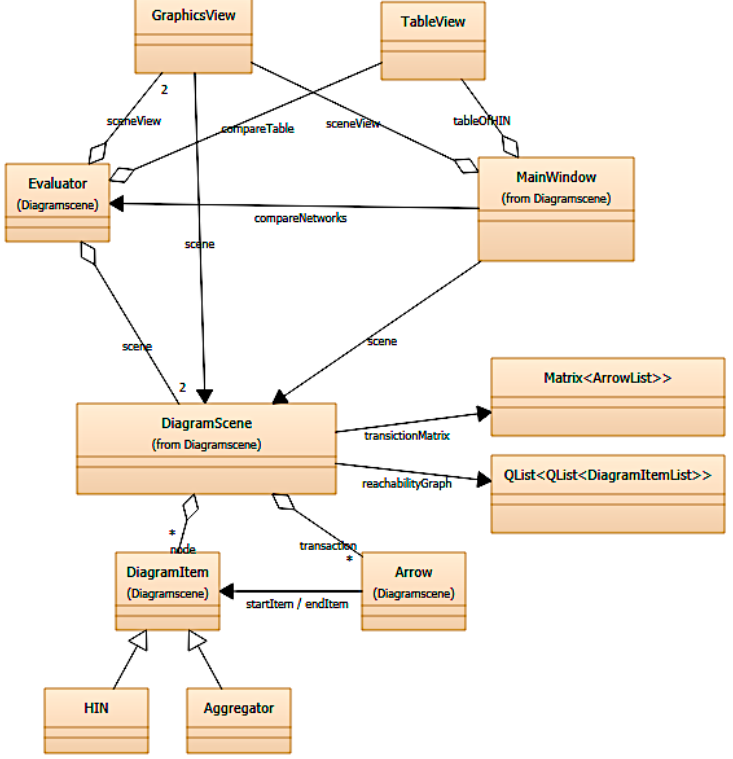
Figure 3. Class diagram highlighting the main application components (‡ highlights the multiplicity of the relevant association)